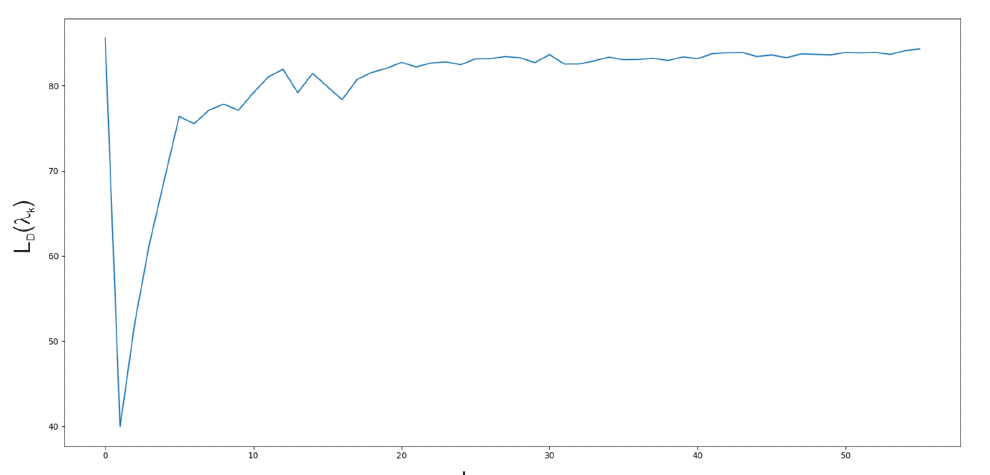
Figure 6. Dual function value during proximal cutting plane coordination algorithm iterations. Continuous and binary variables decomposition for P alt , medium problem, instance 1.